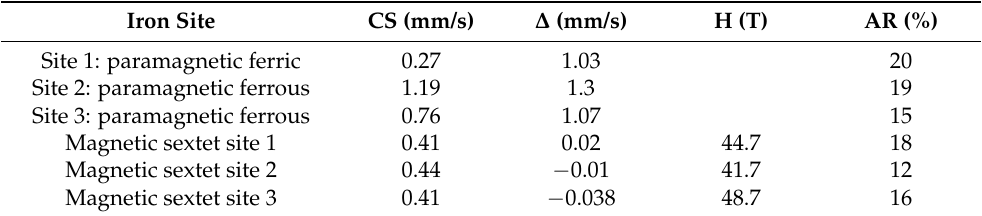
Table 2. Mössbauer parameters and distribution of magnetic and paramagnetic fractions from Mössbauer spectroscopy results of EAF slag at room temperature (298 K).